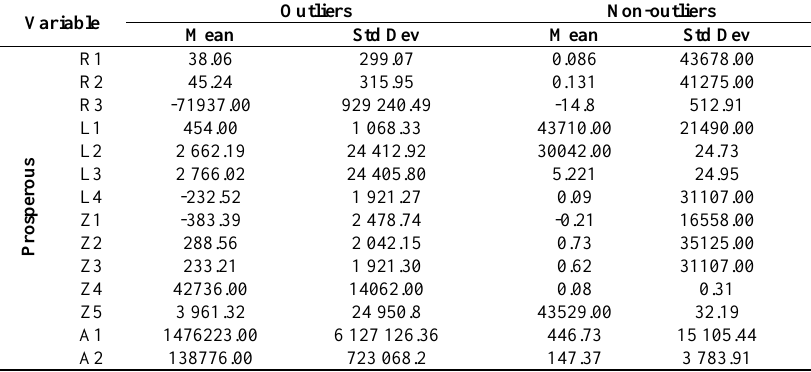
Table 3. Statistical characteristics of prosperous and non-prosperous sets of outliers and